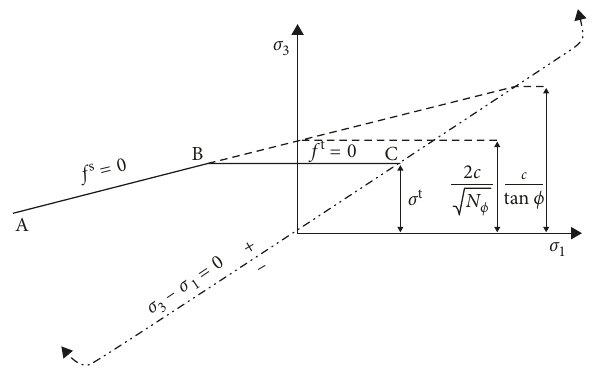
Figure 1: The Mohr–Coulomb failure criterion used for